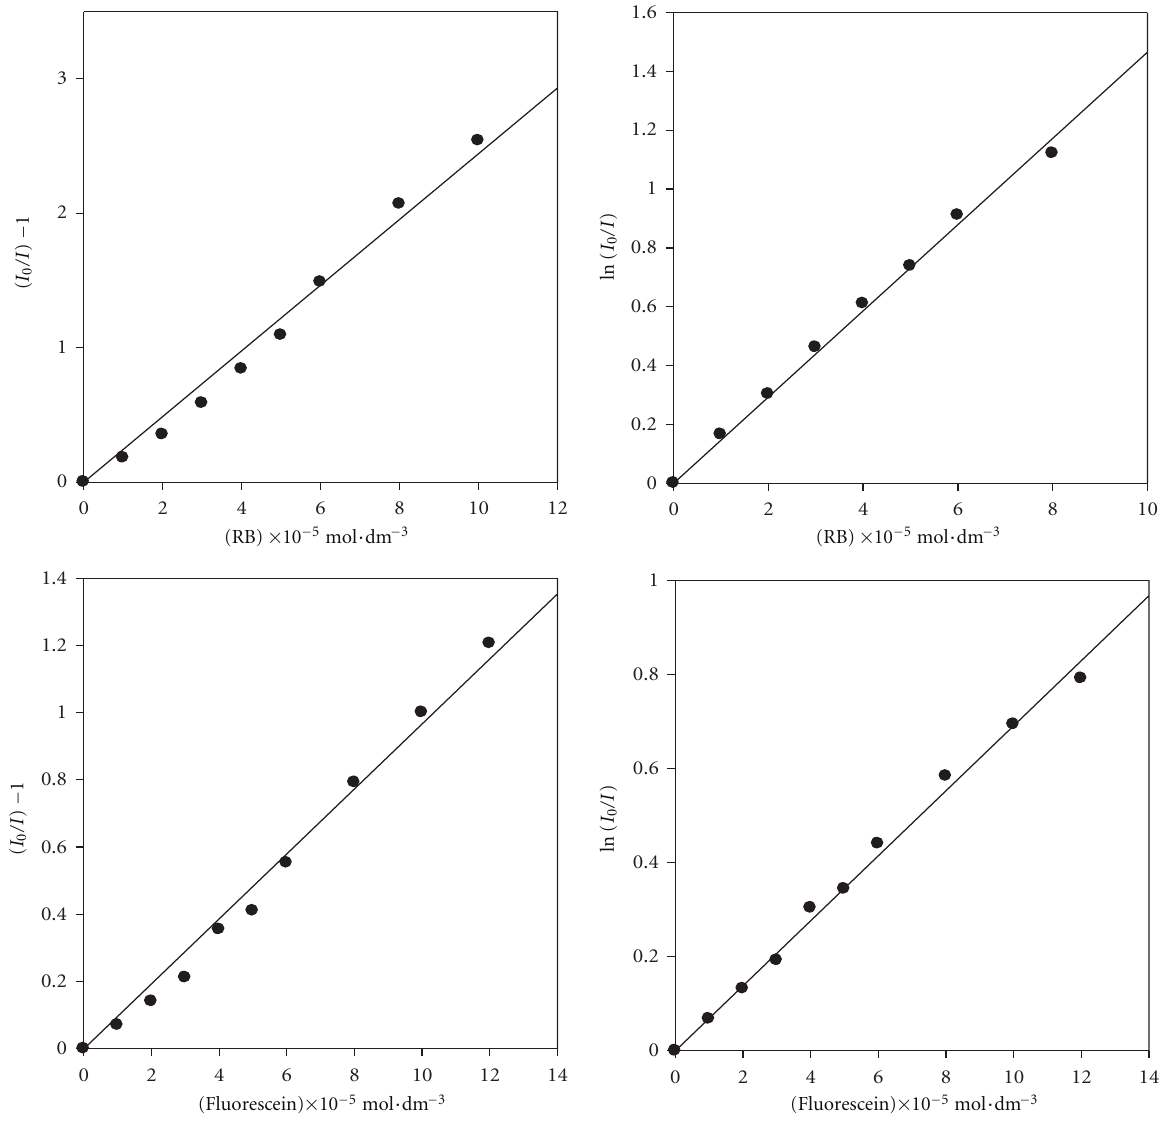
Figure 6: Stern-Volmer plots for fluorescence quenching of 1 × 10 − 5 moldm − 3 POPOP by RB and fluorescine in methanol ( λ ex = 337